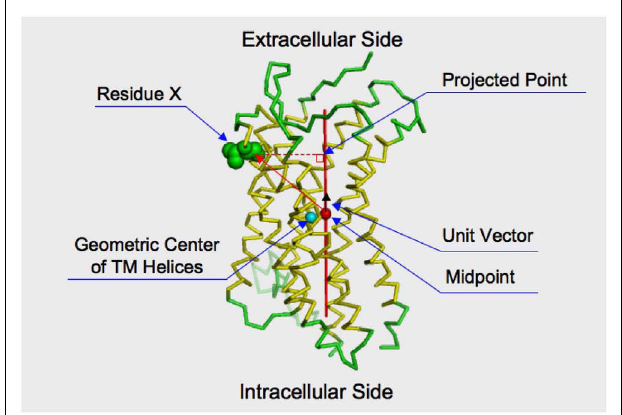
FIGURE 1 | Projection of a residue on the axis connecting the intracellular and extracellular sides of the receptor. The structure of CXCR4 is shown by the ribbon model.The membrane spanning helices indicated by the structural element page for CXCR4 in GPCRDB (http://www.gpcr.org/7tm/) are colored yellow.The sphere colored cyan indicates the geometric center of the alpha carbons of the membrane spanning helices.The red axis connects the geometric center of extracellular loops and the N-terminal loop and that of the intracellular loops.The midpoint of the axis is indicated by a filled sphere colored red. The distance between the cyan and red spheres is close (3.26Å).That is, the midpoint is considered to roughly reflect the geometric center of the transmembrane helices. How to take the orthogonal projection of an amino acid residue to the axis is shown by using Residue X. Consider a vector from the midpoint to the C α atom of the residue. By taking an inner product between the vector and a unit vector, which runs along the axis and is originated from the midpoint.The projected point is obtained by taking the inner